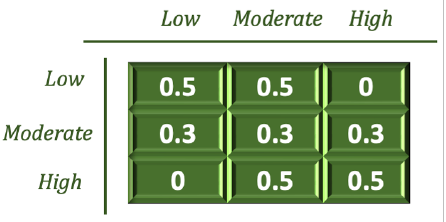
Figure 17. Transition Probability Model of Traffic Monitoring Scenario.